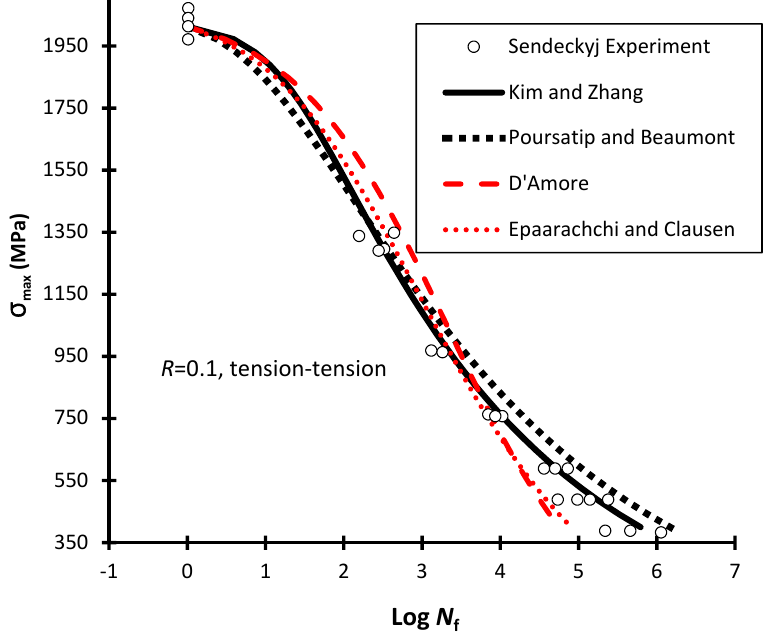
Figure 11. Sendeckyj experimental data at R = 0.1 for glass reinforced epoxy laminates with σ uT = 2013 MPa [19] under T-T loading, and S-N curves obtained from: Kim and Zhang model with α = 10 − 26.505 , β = 7.3813, and N 0 = 1; Poursatip and Beaumont model with α = 60 and added N 0 = 1; D’Amore with α′ = 0.033 and β = 0.44; and Epaarachchi and Clausen model with α′ = 0.00035 and β = 0.51.